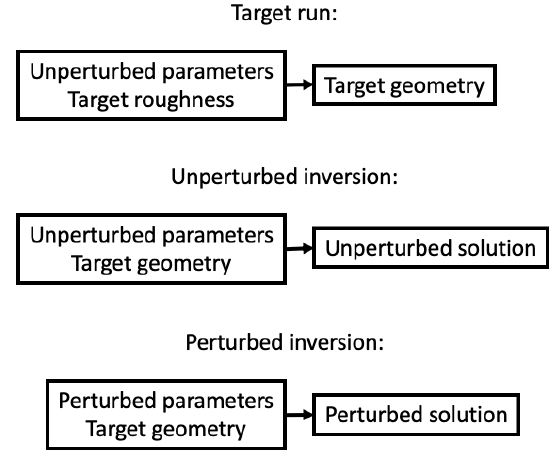
Figure 1. Schematic illustration of the perfect-model approach used in this